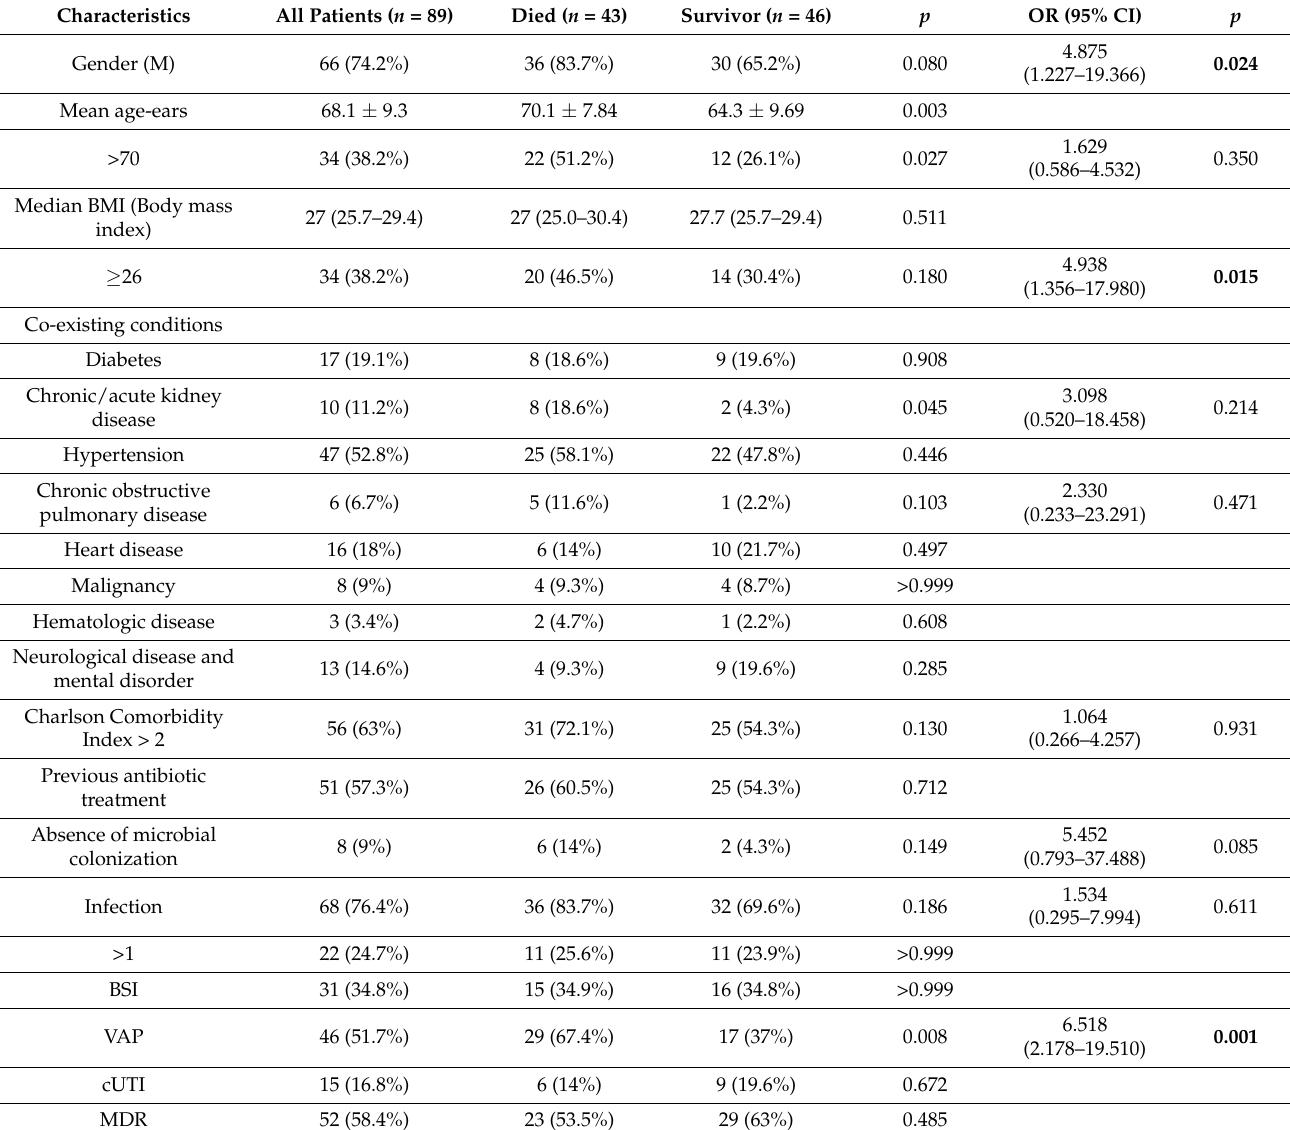
Table 1 Data are expressed as mean ± SD, median (IQR) or n (%). p -values indicate differences between deceased and surviving patients. p < 0.05 was considered statistically significant. Statistically significant values are expressed in bold font. In round brackets are expressed percentages and IQR. BMI: body mass index; BSI: bloodstream infection; VAP: ventilator-associated pneumonia; cUTI: catheter-associated urinary tract